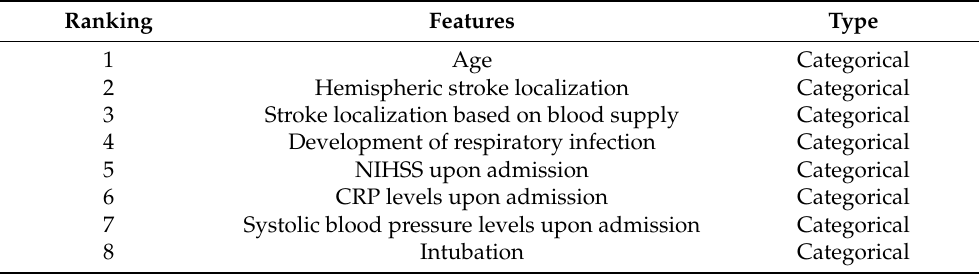
Table 3. Ranking according to the feature significance of the selected characteristics from the best ML model (RF) at the binary problem independent vs. non-independent.